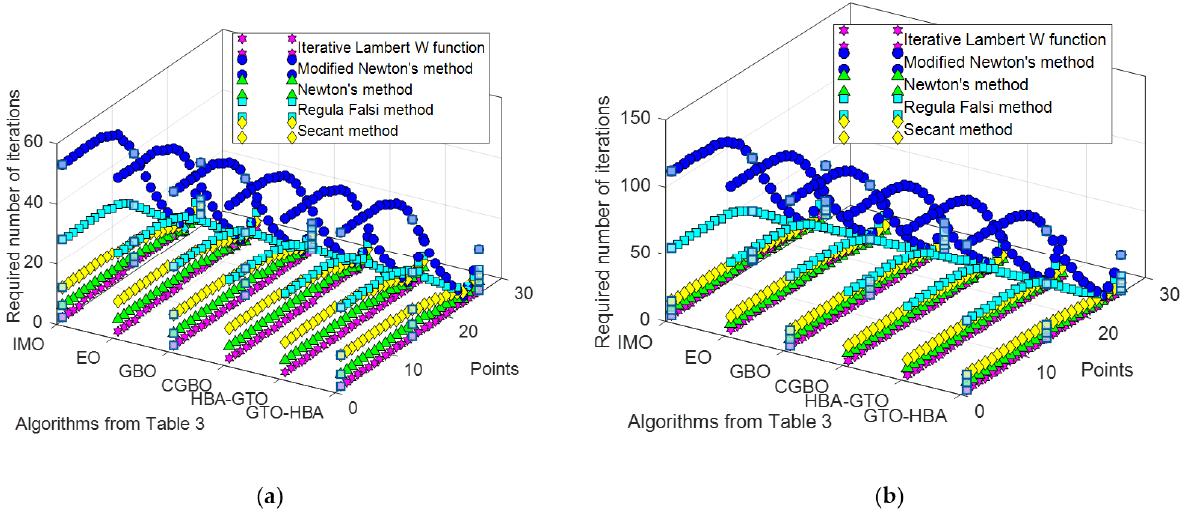
Figure 12. Comparison of the different methods investigated in terms of the required number of iterations for x 0 = 1 with two stopping criteria: ( a ) 10 − 5 ; ( b ) 10 − 10 .